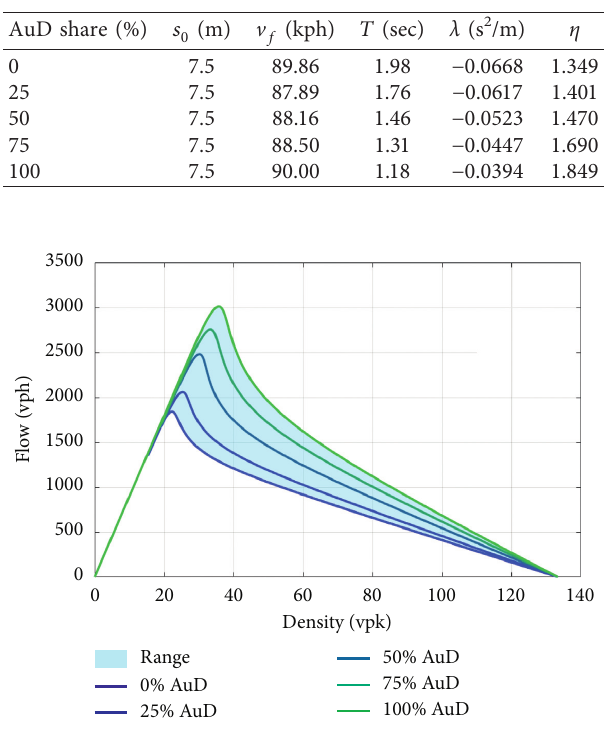
Figure 5: Resulting fundamental diagrams for distinct mixed traffic conditions generated from numerical